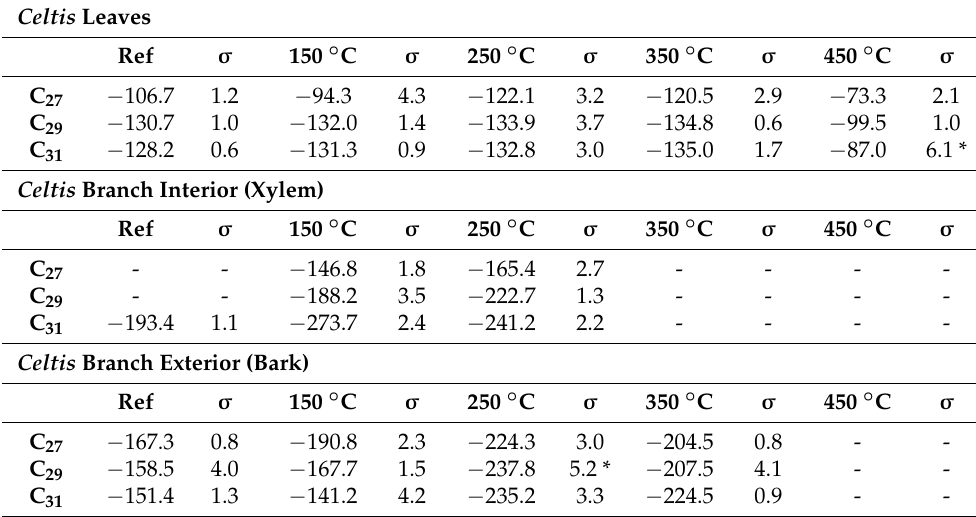
Table 2. Hydrogen isotope values of individual long-chain n -alkanes in thermally unaltered reference samples and heated samples of Celtis australis leaf, branch interior (xylem), and exterior (bark). The δ 2 H wax values are normalised to the Vienna Standard Mean Ocean Water (VSMOW) standard. Values are expressed in per mil (‰) with one standard deviation. Ref indicates unheated reference samples and * denotes samples where reproducibility was less than ± 5.0‰ following three replicates. Celtis